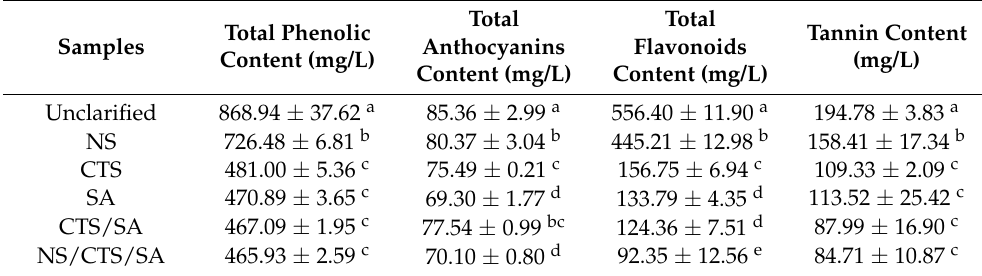
Table 3. Effects of different clarification methods on total phenolic, total anthocyanins, total flavonoids, and tannin content of bayberry